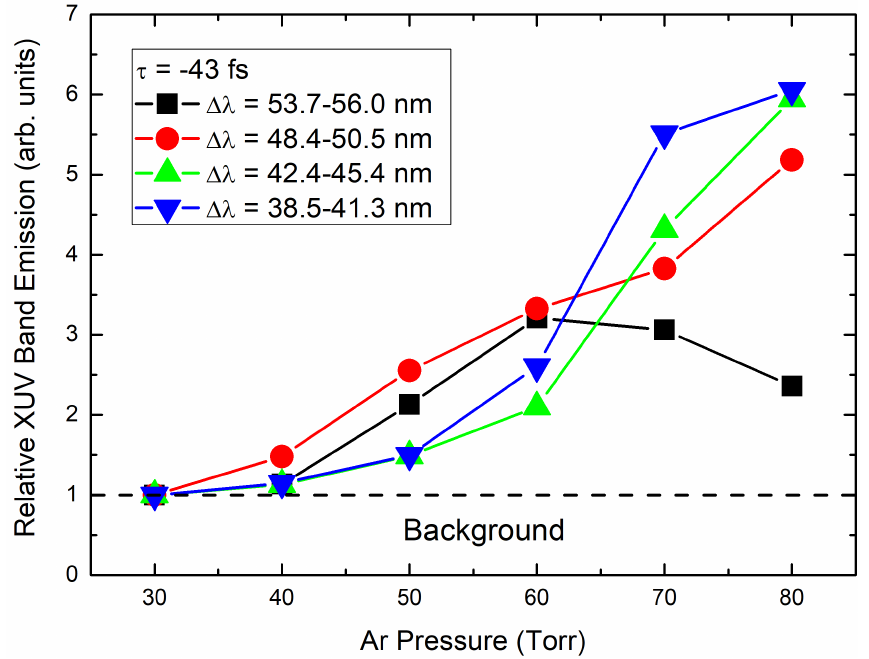
Figure 4. Relative enhancement of the measured XUV band emission for the spectral areas between the harmonics as a function of the generating gas pressure. The data correspond to those of Figure 3 for the pulse duration of τ = − 43 fs. Relative XUV band emission error bars are estimated lower than 1% and are within the data